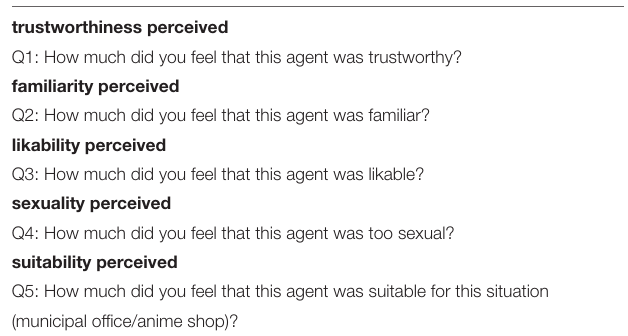
TABLE 1 | Speech text for two levels for context. TABLE 3 | Questions I used in the